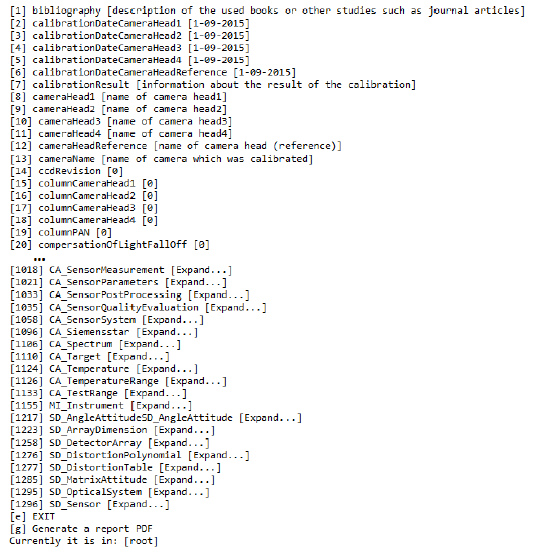
Figure 3. Screenshot of the new